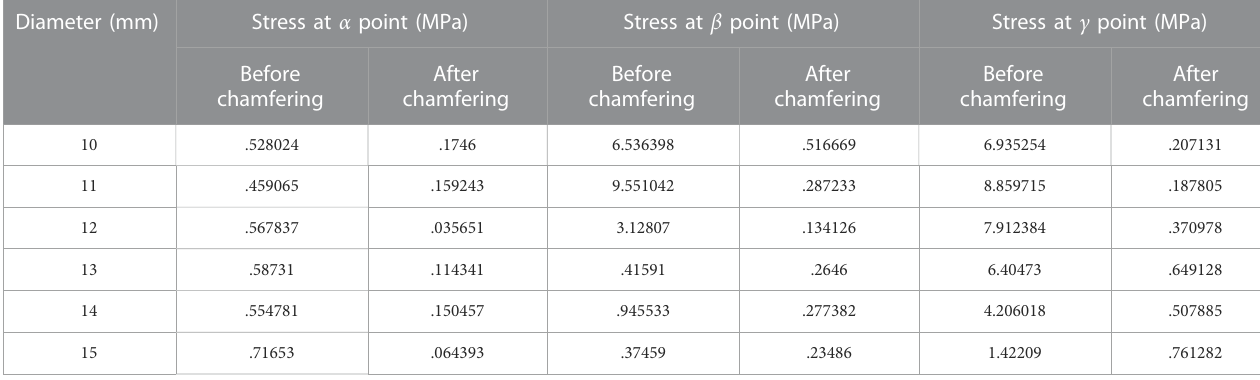
TABLE 7 Stress at α , β , and γ positions when removing the orbital wall in a circular shape. Diameter (mm) Stress at α point (MPa) Stress at β point (MPa) Stress at γ point (MPa) After Before After Before After Before chamfering chamfering chamfering chamfering chamfering